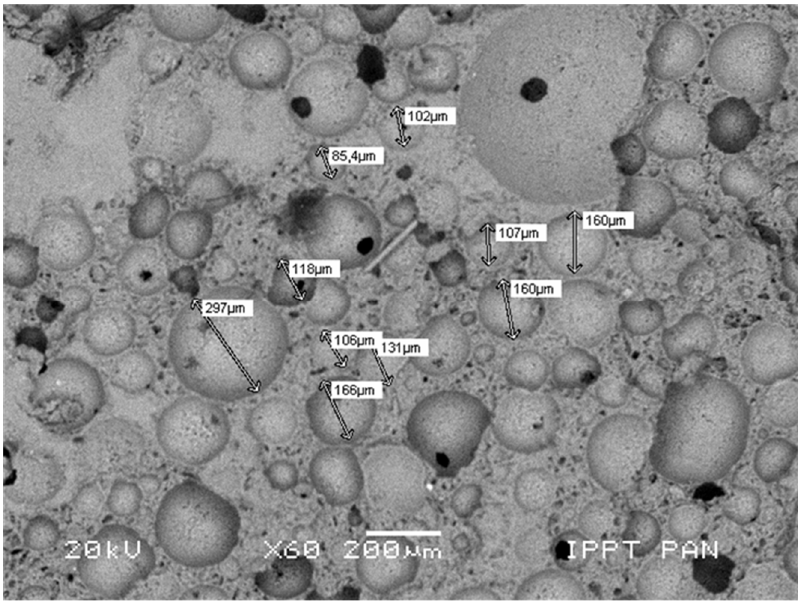
Figure 5. Microstructure of foamed gypsum matrix, with various sizes of pores.